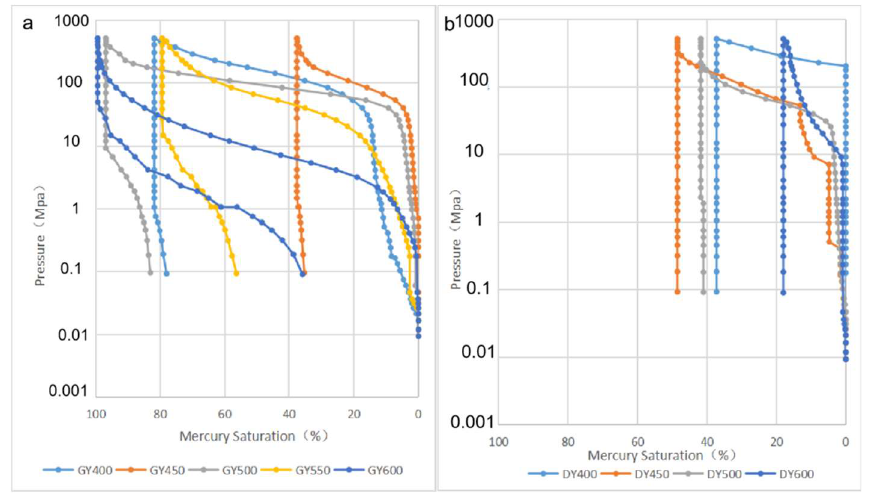
Figure 7. Mercury intrusion experiment curve. ( a ) Semiclosed and ( b ) open systems.